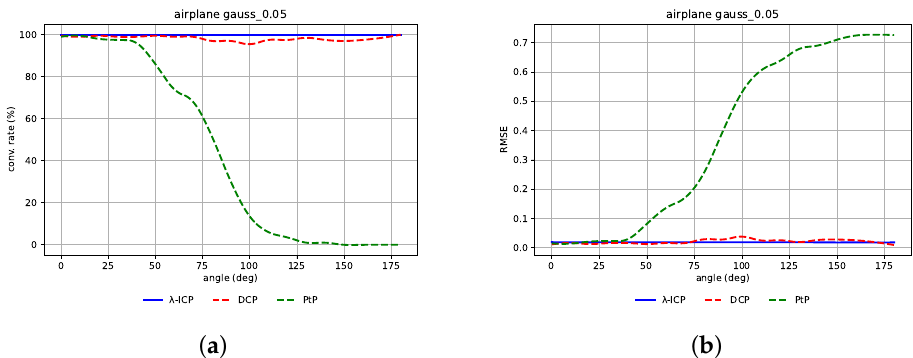
Figure 10. ( a ) Convergence rate of λ -ICP (blue), DCP (red), PtP (green) algorithms for airplane with Gaussian noise, σ = 0.05; ( b ) mean RMSE (for transformation matrices) of λ -ICP (blue), DCP (red), PtP (green) algorithms for airplane with Gaussian noise, σ = 0.05.